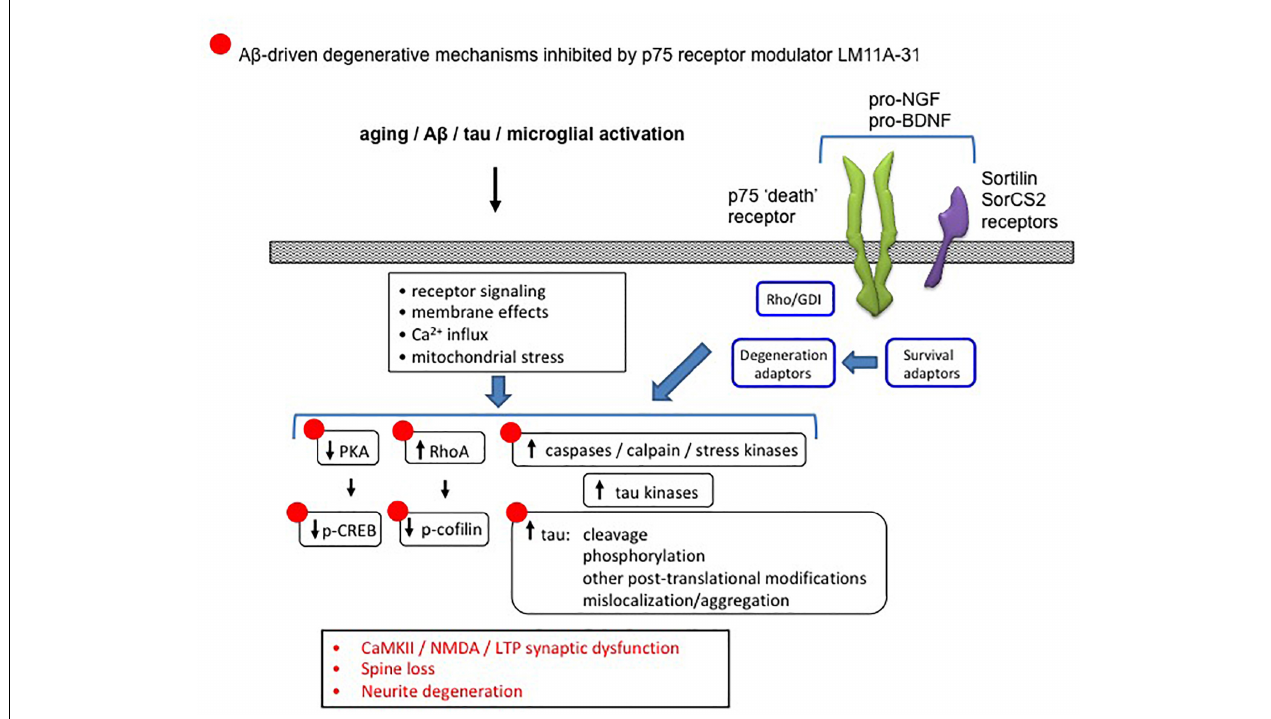
FIGURE 12 | Diagram showing the association between p75 NTR and Alzheimer’s-related degenerative signaling networks. Aging, A β and other processes produce numerous changes in signaling pathways involved in neurite and synapse function and degeneration. Degenerative signaling promoted by p75 NTR in either its unliganded state, or in response to proneurotrophin binding to p75 NTR and its sortilin family co-receptors, and mediated through one or more receptor adaptors enables or promotes AD-related degenerative processes. LM11A-31, which interferes with proneurotrophin degenerative signaling and promotes supportive/survival signaling through p75 NTR , reverses many of these AD-associated effects (indicated by • ).